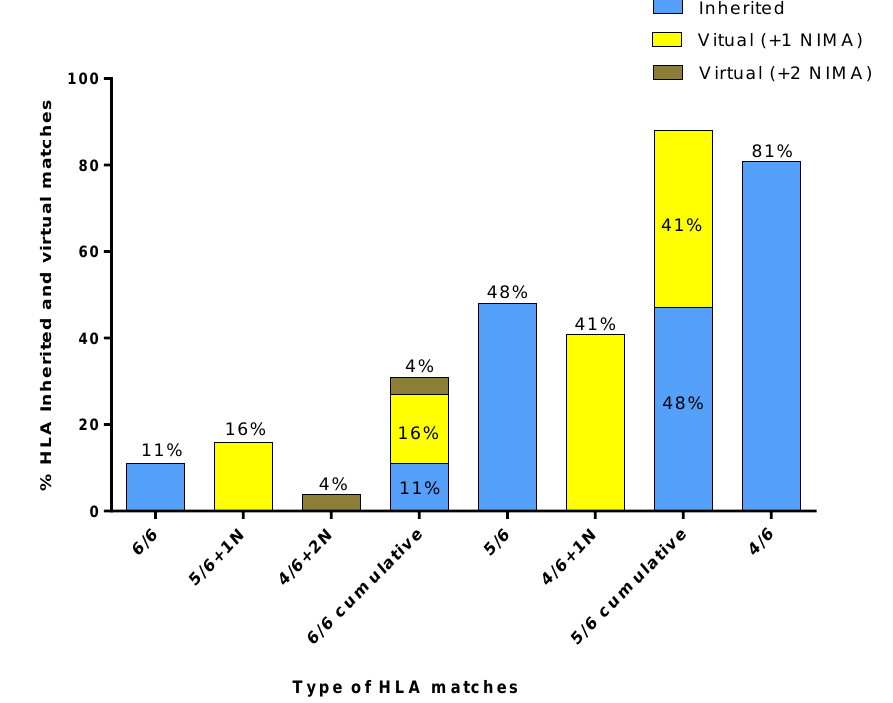
Figure 6. Results of matching the 80 Greek patients against the HCBB’s CBUs and the VPs of the “VP database”.